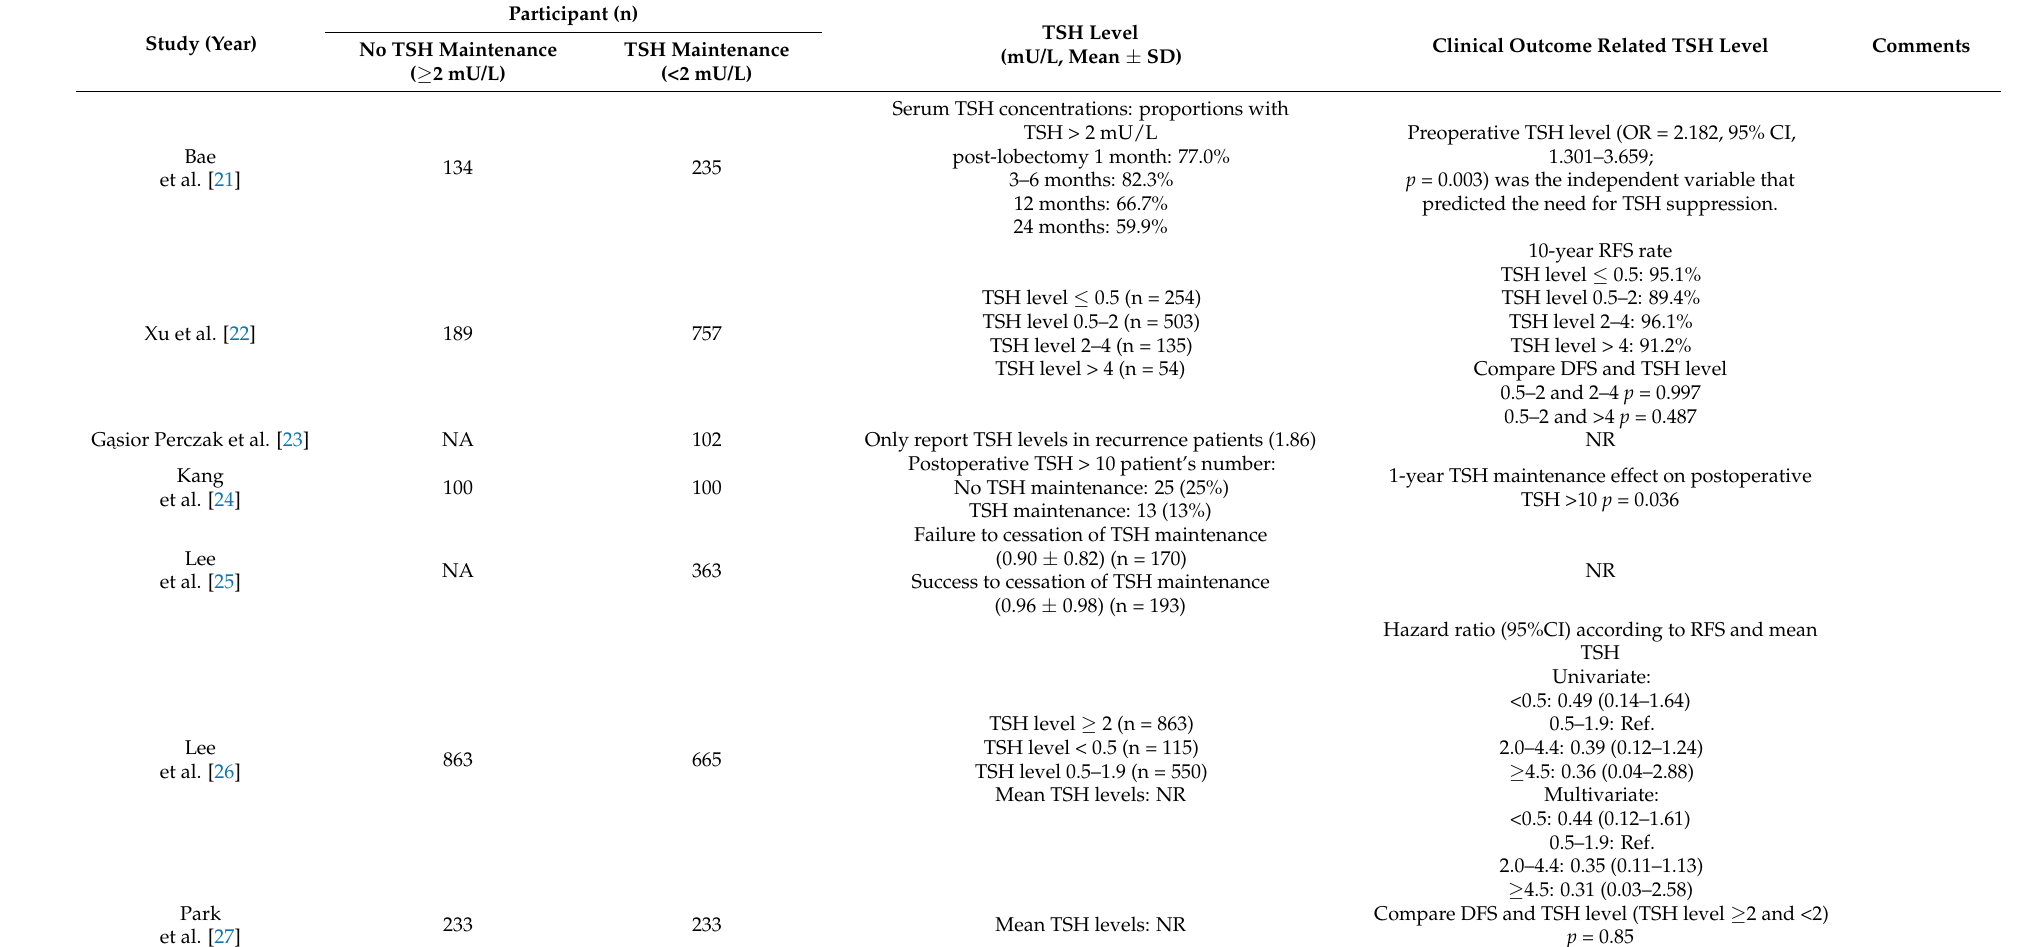
Table 4. TSH levels reported in studies included in the systematic review and